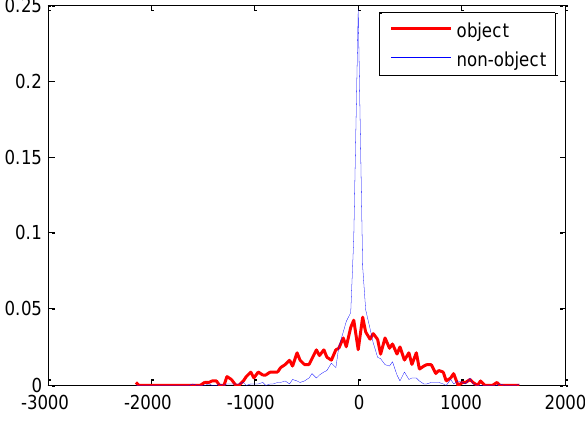
Figure 4. Typical distribution of feature values in later stages of boosting on the training data (described